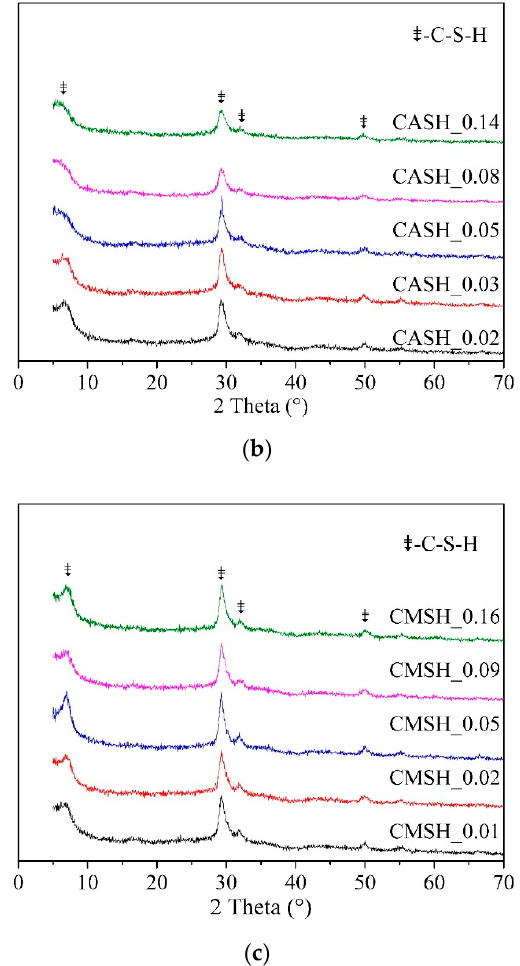
Figure 1. X-ray diffraction (XRD) analysis of synthesized C-(M)-(A)-S-H: ( a ) Ca/Si; ( b ) Al/Si; ( c ) Figure 1. X-ray di ff raction (XRD) analysis of synthesized C-(M)-(A)-S-H: ( a ) Ca / Si; ( b ) Al / Si; ( c ) Mg / Mg/Si.